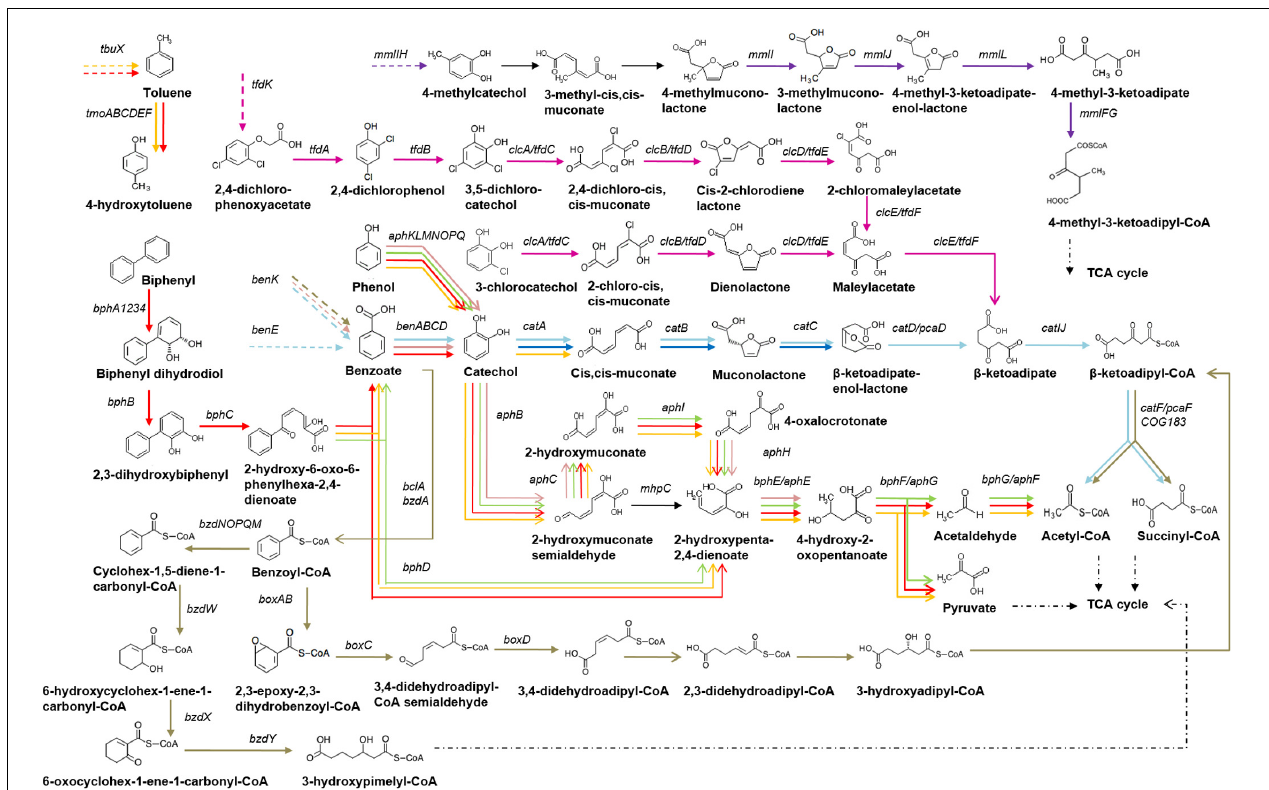
FIGURE 1 | Scheme of benzoate, phenol, biphenyl, toluene, 2,4-dichlorophenoxyacetate, 3-chlorocatechol and 4-methylcatechol utilization and its regulation in Betaproteobacteria. Dashed arrows denote transporters, arrow color denotes regulation by the following TFs: AphS/BphS – red, AphR – orange, AphT – green, BenR – pink, BoxR/BzdR – brown, CatR and/or CatM/BenM – light blue, CatR ∗ – dark blue, ClcR and TfdR(S) –